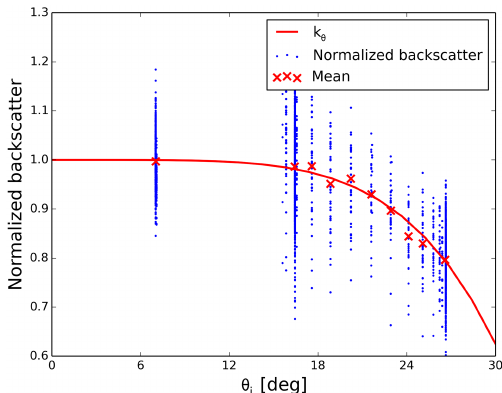
Figure 5. Atmospheric signal (blue) from 26 June averaged be- tween 3 and 4km after correcting for acquisition board gain (a) , for system gain as a function of the beat signal frequency (b) and additionally for the system gain as a function of the angle of inci- dence of the laser beam (c) . Beat signal frequency ( a , red). Angle of incidence of the laser beam ( b , green).